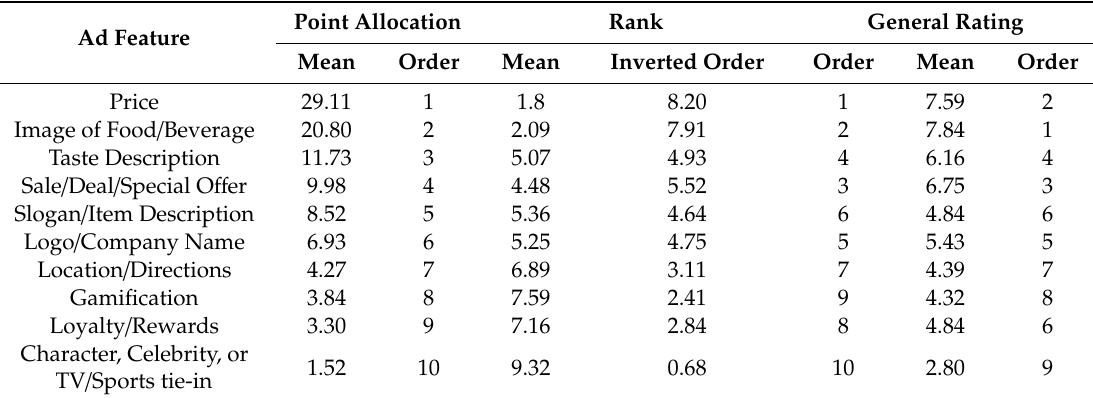
Table 2. Weighting methods for the coding tool ( n = 44).